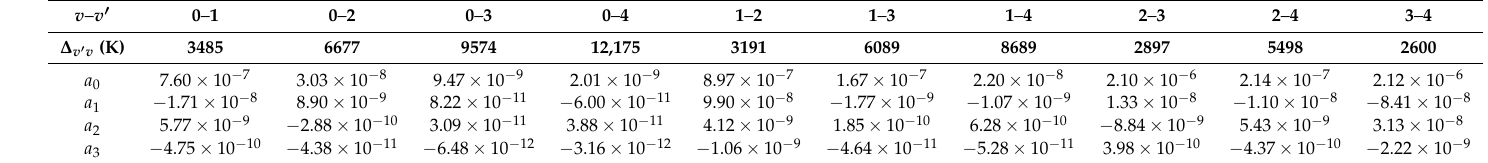
Table 6. Same as Table 3 for 3 HeD +